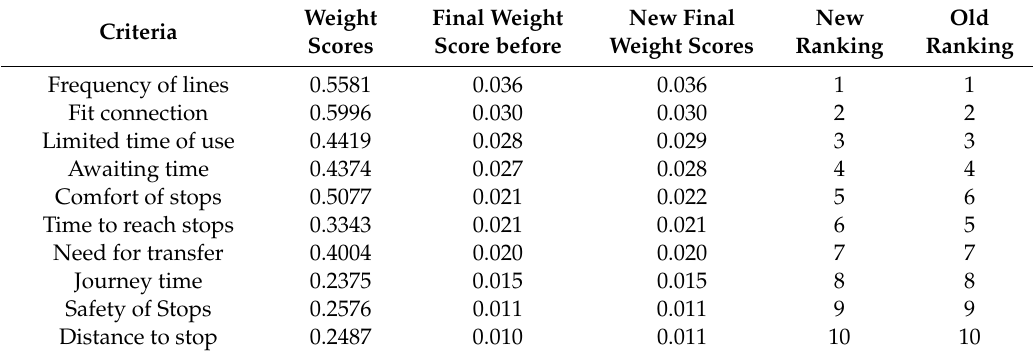
Table 9. Weight scores and ranking after the sensitivity check for level